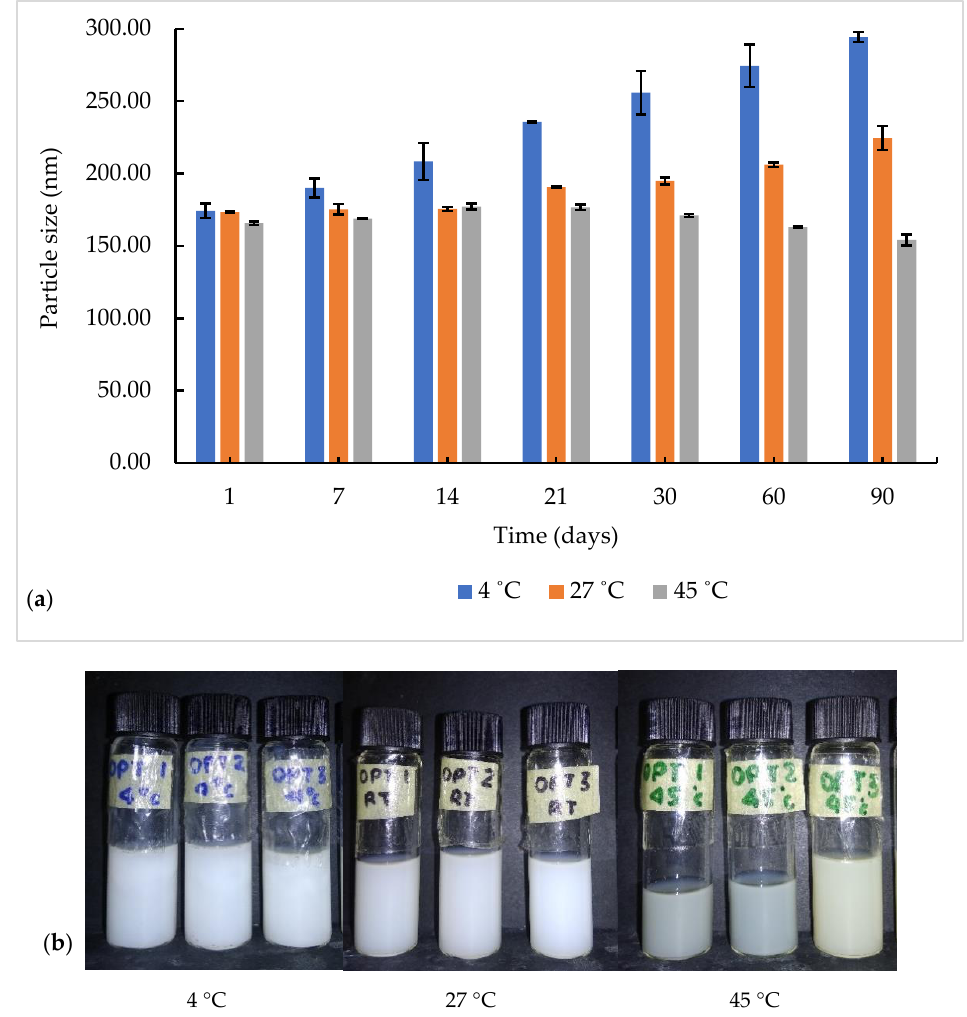
Figure 3. ( a ) Particle size as a function of time at different storage temperatures for 90 days. ( b ) Physical appearance of NGC formulation after 90 days.